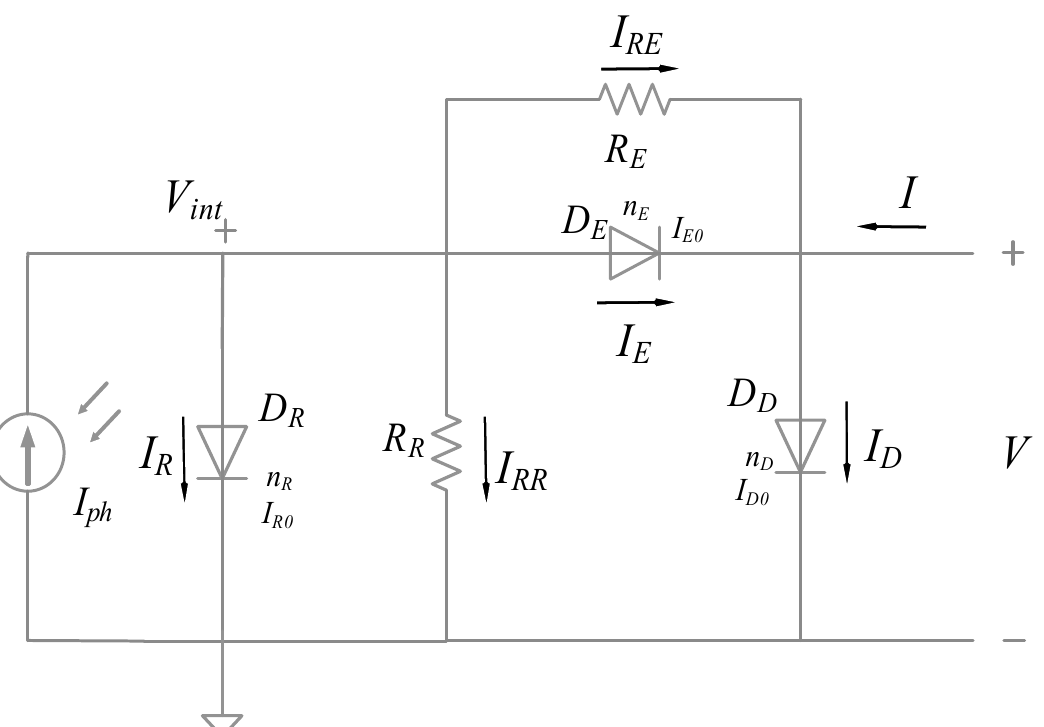
Figure 2. Improved lumped-parameter equivalent circuit of OSCs.